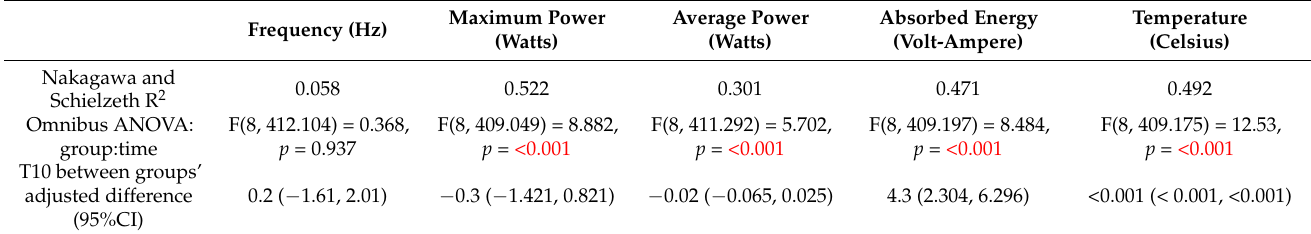
Table 3. Radiofrequency parameters between both legs: model results.